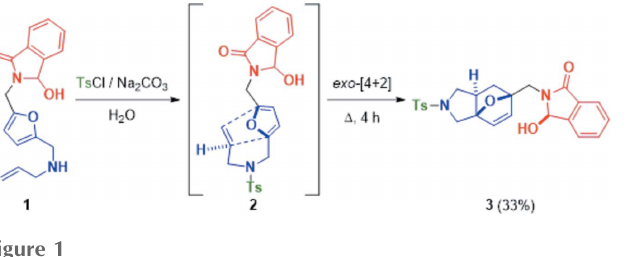
Figure 1 Synthesis of the title compound 3